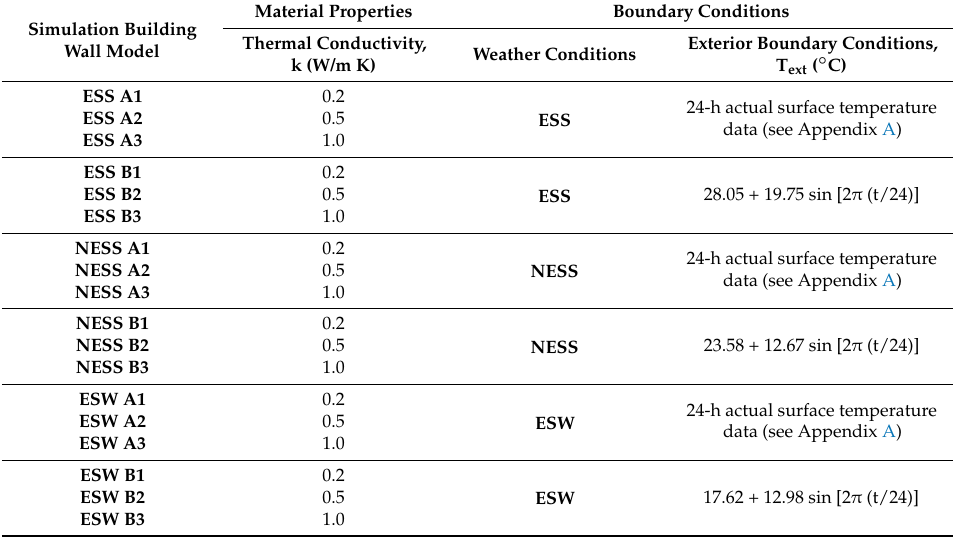
Table 4. Building wall properties and boundary conditions of numerical simulation study for the building wall models under